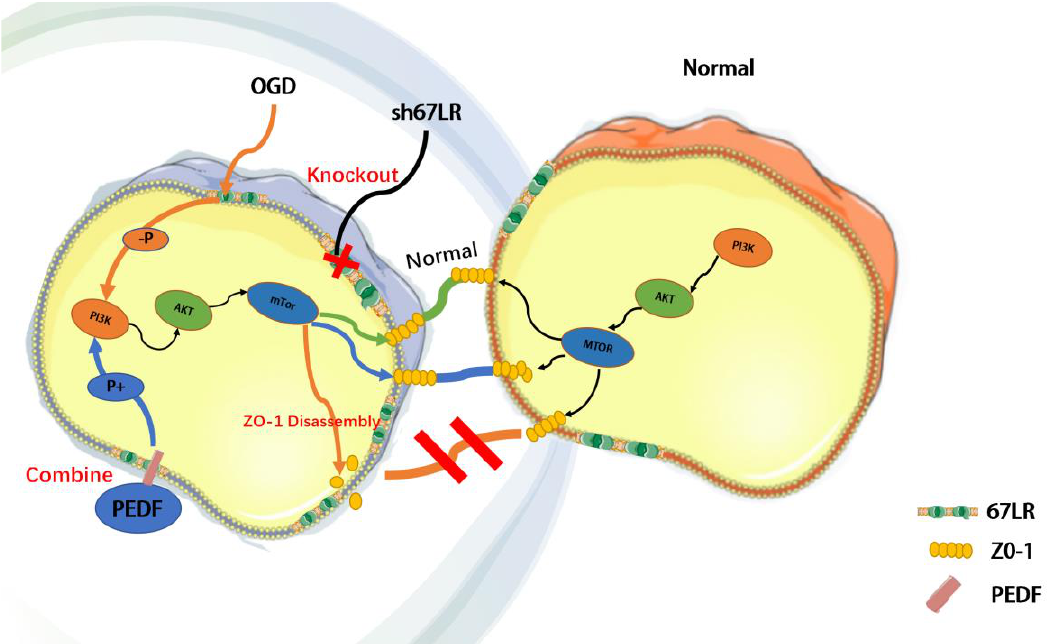
Figure 6. Schematic diagram demonstrating that PEDF maintains the stability of TJs by activating the PI3K-AKT-mTOR pathway via the 67LR receptor under OGD conditions.